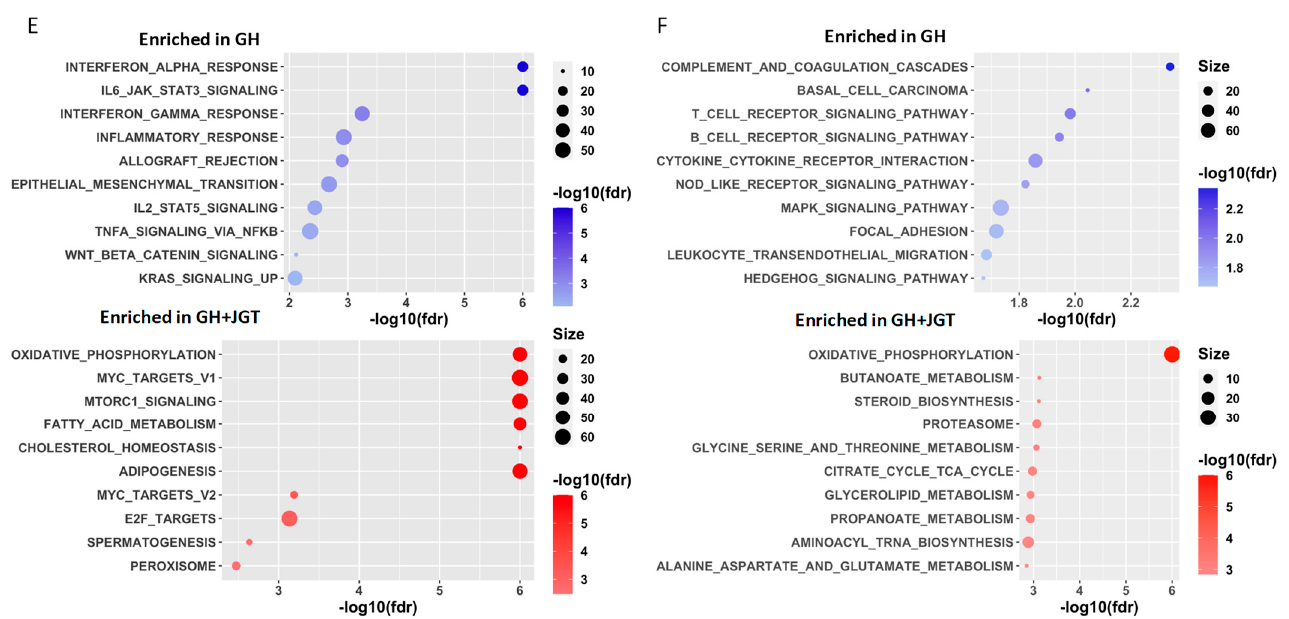
Figure 4. Cancer Hallmark pathways and KEGG pathways enriched in GH and SI treated or not with JGT. Top 10 signi fi cantly di ff erent Cancer Hallmark and KEGG pathways, generated from RNA-Seq data in mammary glands ( A , B ) between the group-housed (GH) and socially isolated (SI) rats after tamoxifen therapy, ( C , D ) between SI and SI rats treated with JGT after tamoxifen therapy, and ( E , F ) between GH and GH rats treated with JGT during tamoxifen therapy. The color of bubbles represents − log10(fdr). The size of bubbles represents the number of signi fi cantly di ff erent genes that contributed to the enrichment score.